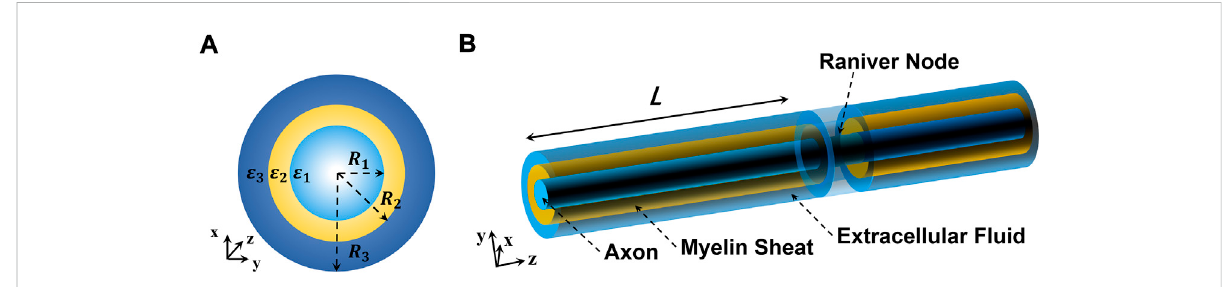
FIGURE 1 Schematic diagram of the nerve fi ber structure. (A) Cross section of the nerve fi ber and (B) 3D perspective graphics of the nerve fi